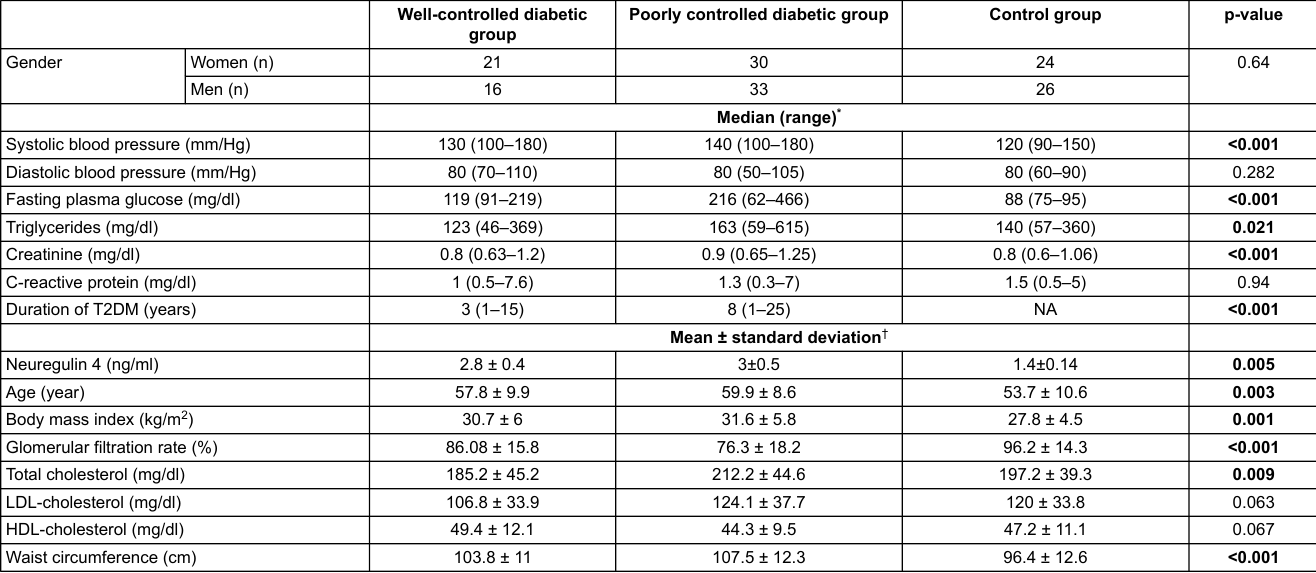
Table 2: Comparison of laboratory data and characteristics in the poorly and well-controlled type 2 diabetes and control